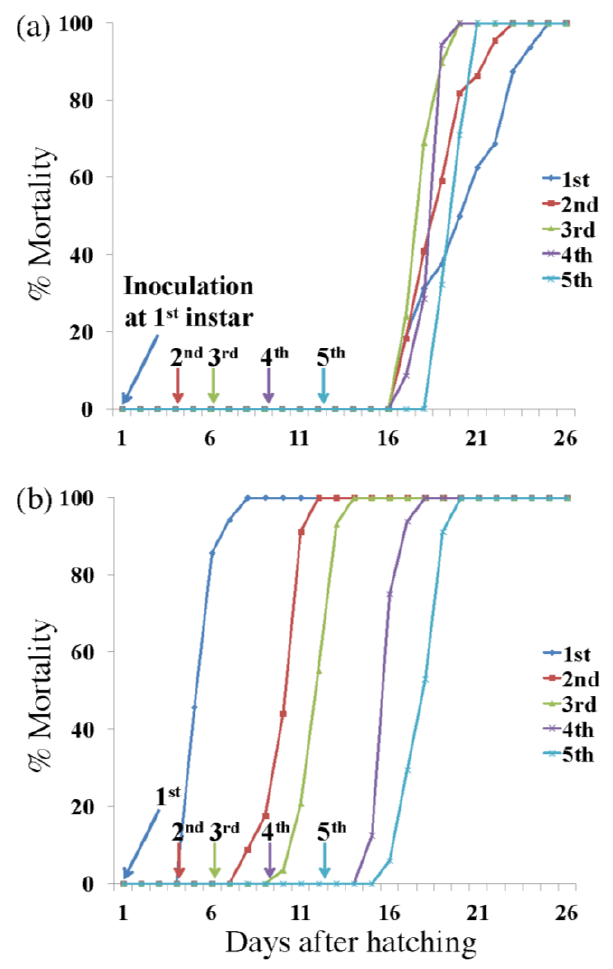
Figure 2. ( a ) Percentage mortality of A. honmai larvae inoculated with AdhoNPV at 1 st , 2 nd , 3 rd , 4 th and 5 th instar; ( b ) Percentage mortality of A. honmai larvae inoculated with AdorNPV at 1 st , 2 nd , 3 rd , 4 th and 5 th